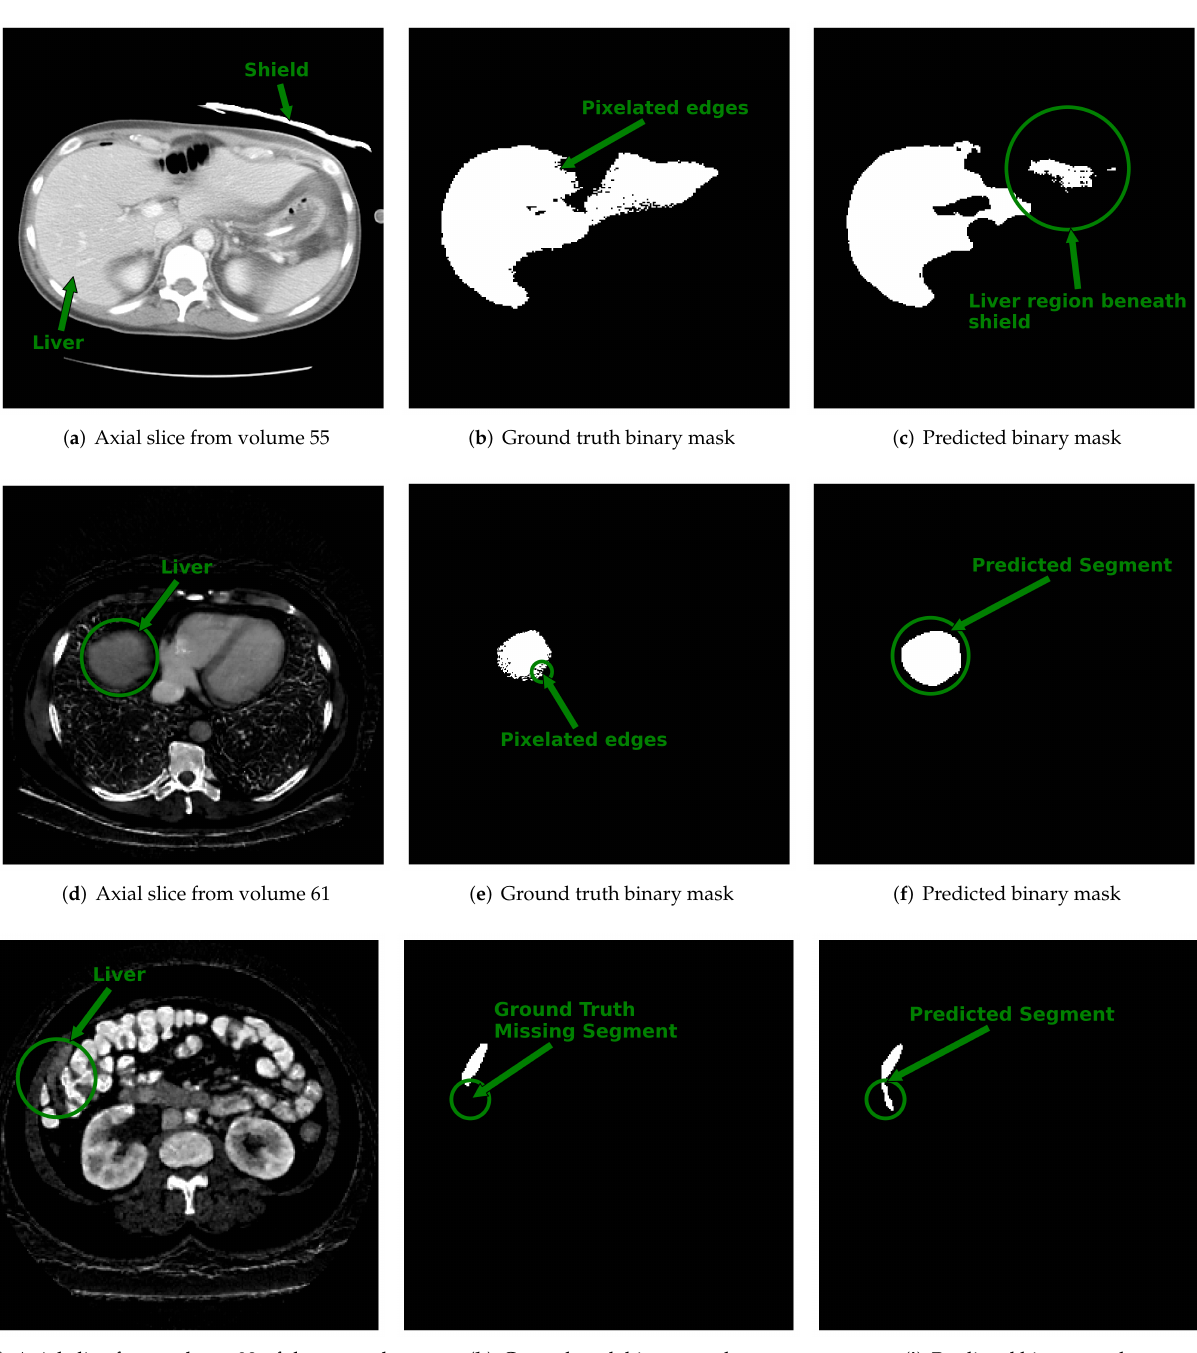
Figure 6. Displayed are example cross sectional axial slices with ground truth annotations and predicted contours from 3D u-net. Top Row: ( a ) Axial slice from single energy CT (SECT) scan of a patient within the CT-ORG training dataset shows an attenuating shield placed over segment 2